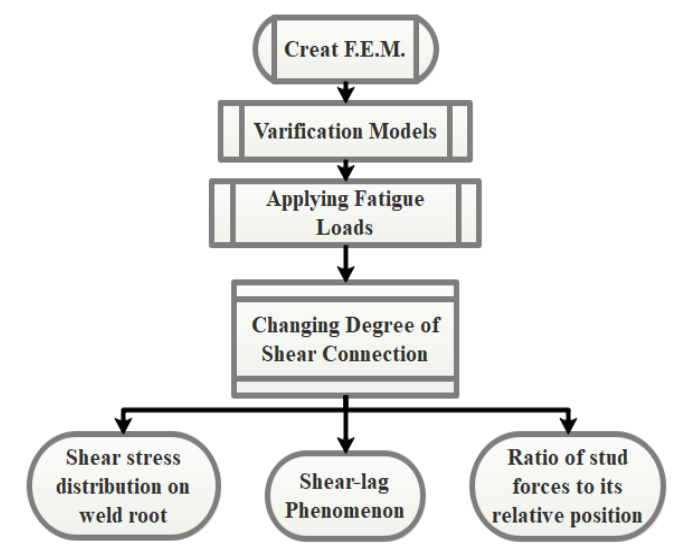
Figure 1: Proposed numerical analysis work in this study